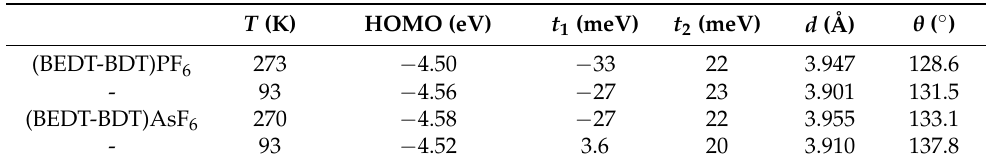
Table 1. Temperature dependence of the HOMO energy, transfer integrals ( t 1 and t 2 ), interplanar distance d , and dihedral angle θ of the BEDT-BDT salts.